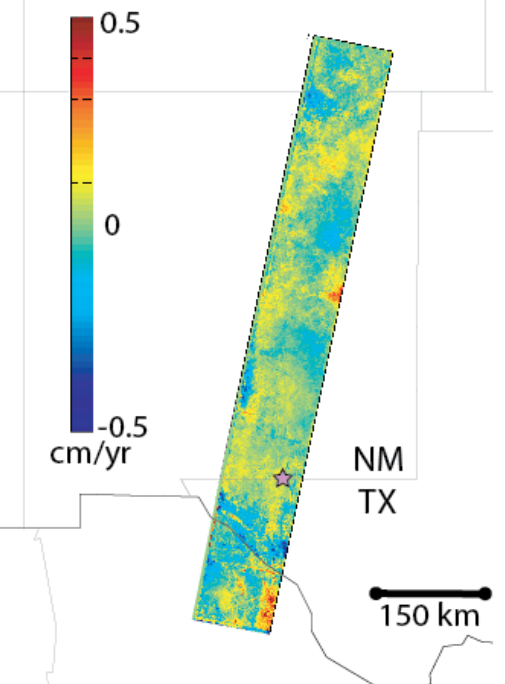
Figure 14. Time series of 116 interferograms from ERS-1/2 from 1992 to 2001 over the Diablo Plateau where leveling studies showed deformation at a low rate during the earlier decades of the 20th century (star, [63]). Most signals visible here are probably related to atmospheric features and there is likely no detectable deformation above the detection